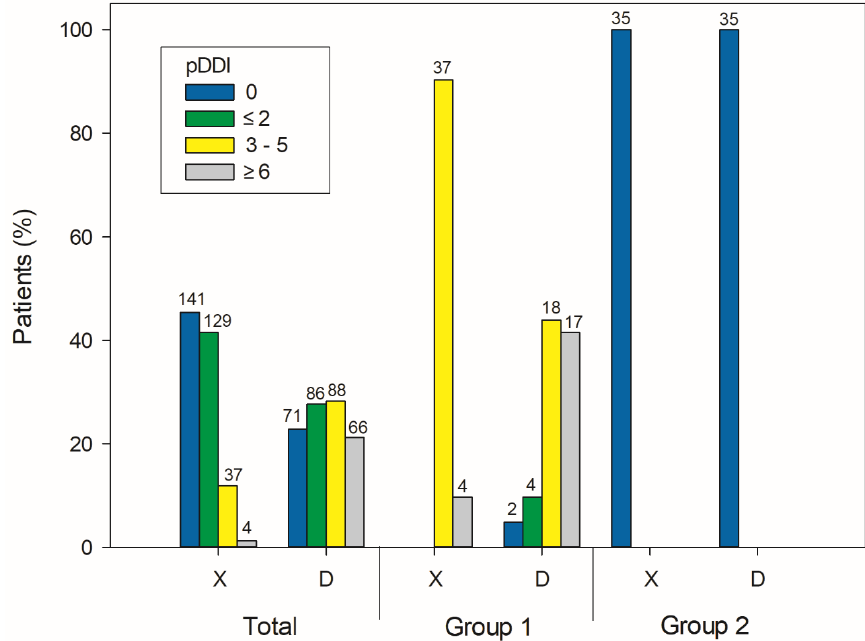
Figure 1. Prevalence of type X and D pDDIs. The total number of patients was 311, with 41 and 35 patients included in group 1 and group 2, respectively. The numbers above the bars indicate the number of patients. Table 2. Ten most common type X pDDIs in all patients (n = 311), the summary of interaction, patient management, severity, and reliability